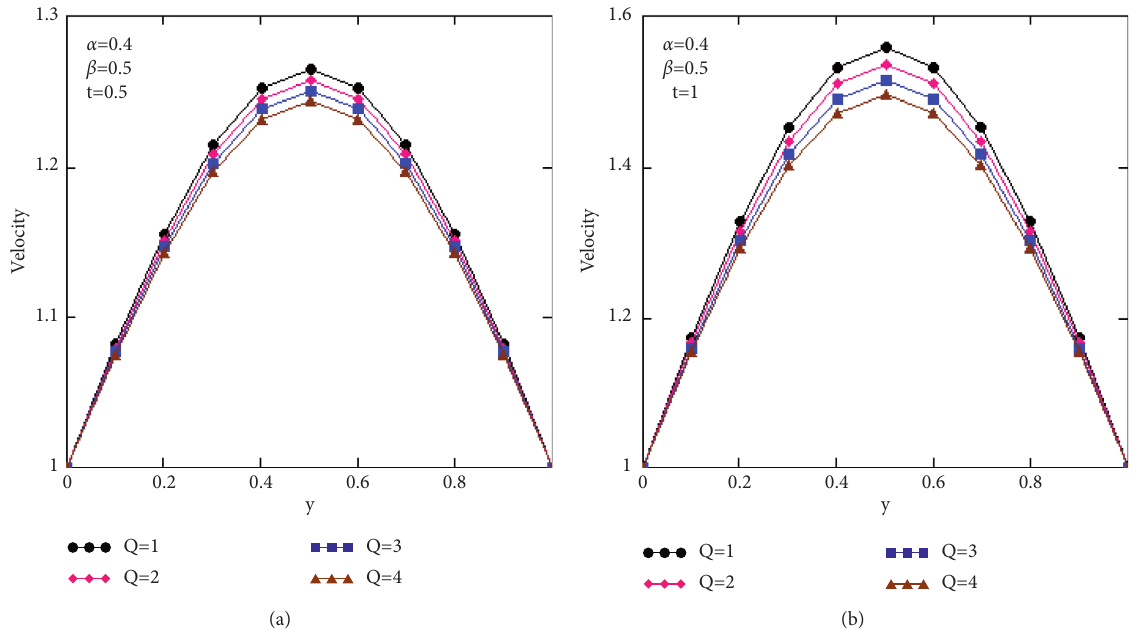
Figure 13: Profiles of dimensionless velocity versus y for variation of Q at altered values of time t , Gr � 5 , λ � 2 , λ ( t ) � f ( t ) � H ( t ) � g f 1 1